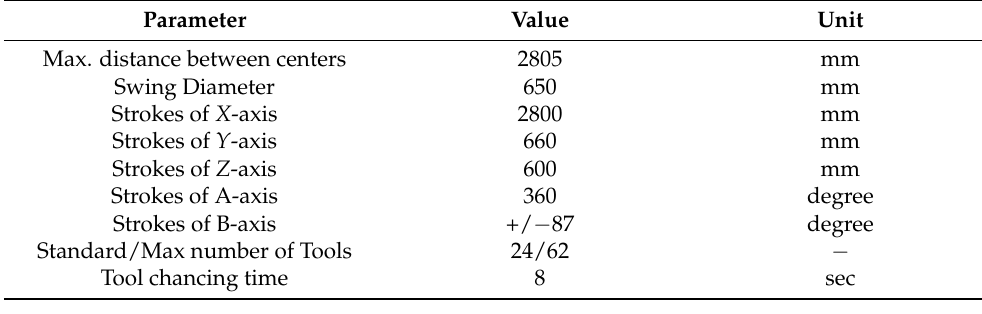
Table 1. The technical data of the machine tool.